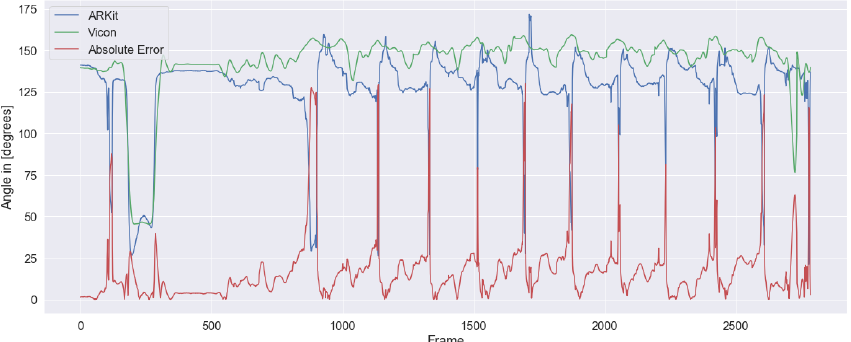
Figure 11. Left elbow angle of one of the subjects in the Single Leg Deadlift exercise, which shows several unexpected spikes during the execution. The spikes originate from ARKit incorrectly detecting the joint’s position, most probably because of bad visibility of the elbow joint during the